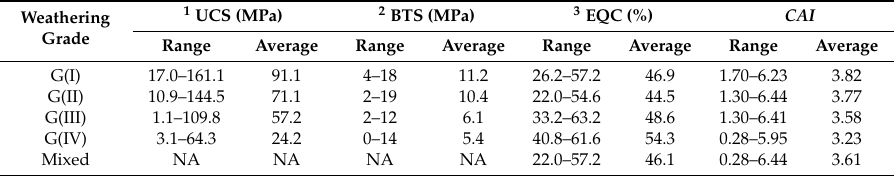
Table 2. Weathering classification for Bukit Timah